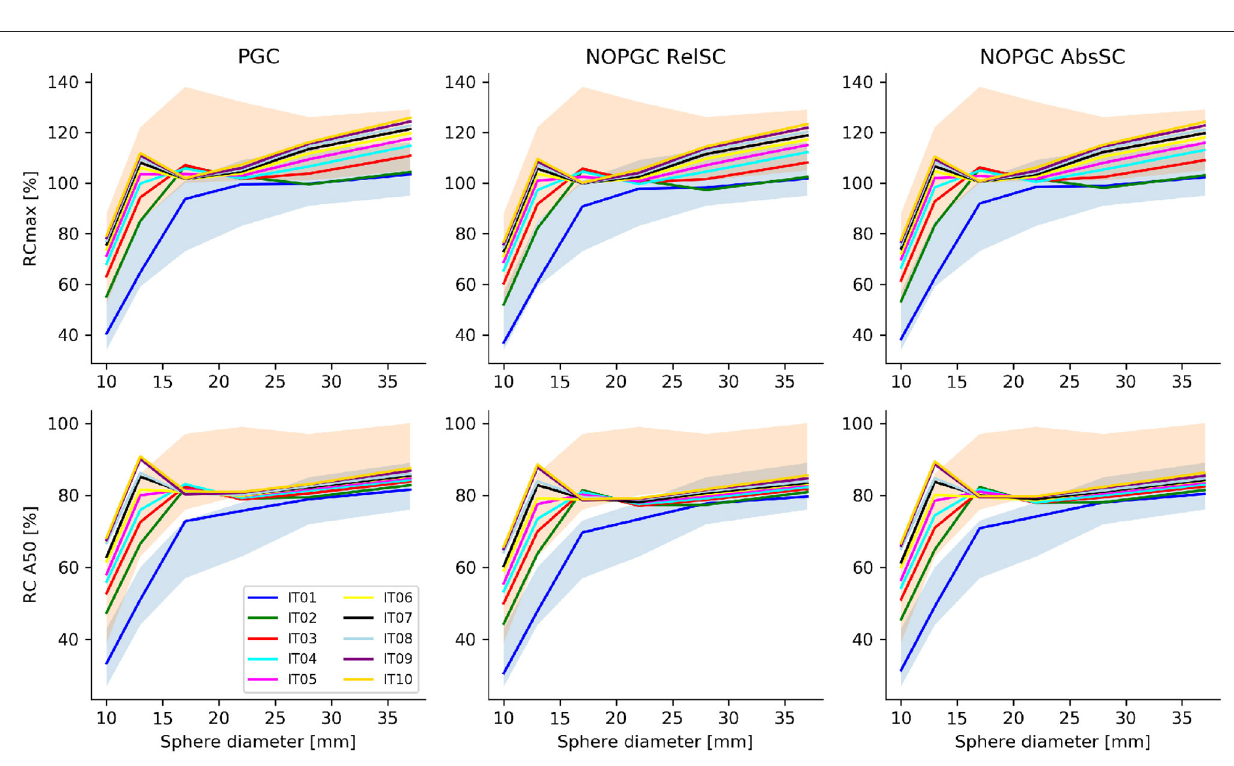
FIGURE 3 | RC max and RC A 50 obtained as a function of the sphere size for the tested number of iterations (from 1 to 10, for a fixed number of 21 subsets) and for the different scatter/PGC tested corrections. The range of RC values recommended in the EANM/EARL accreditation procedure for [ 18 F]FDG PET is indicated in blue. The RC range of values proposed by Kaelep et al. [34] is within the shaded red